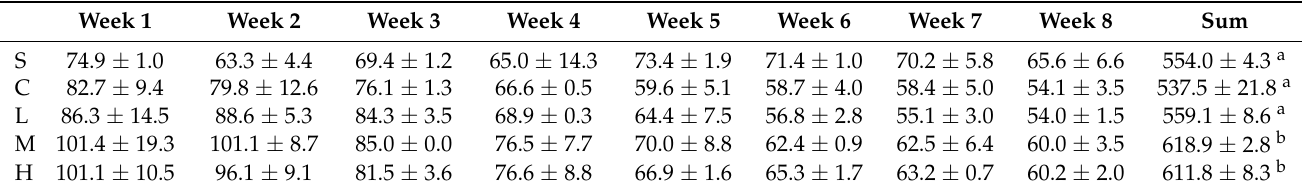
Table 5. Energy intake over the course of SD rats after an ovariectomy (OVX) and a dietary intervention.